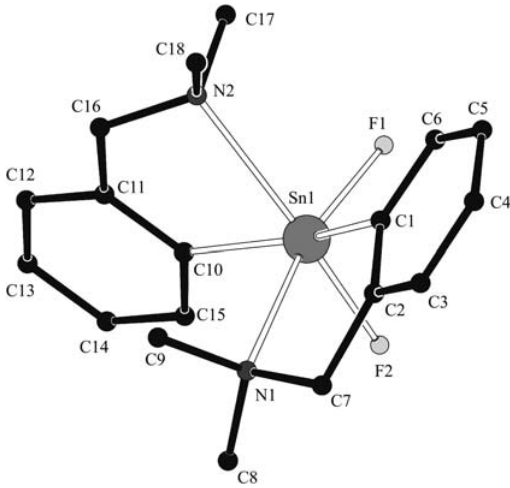
Figure 4 Molecular structure of compound 5 , hydrogens are omitted for clarity. Selected interatomic distances [ Å ] and